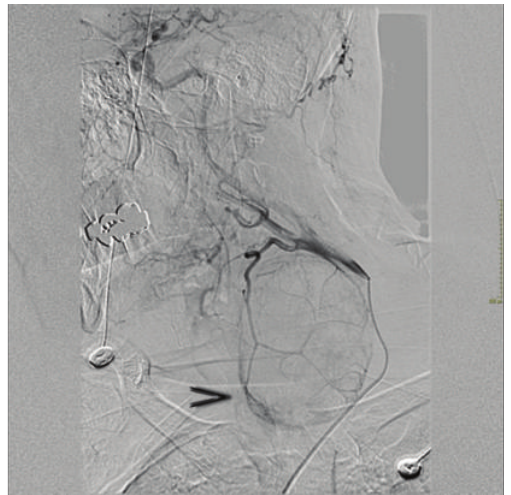
Figure 1: Angiography: the common carotid artery appears per- vious, but displaced laterally to the presence of the hematoma at the left laterocervical level. We appreciate a haemorrhagic suffusion in terms of the superior thyroid artery, on the medial side of the hematoma